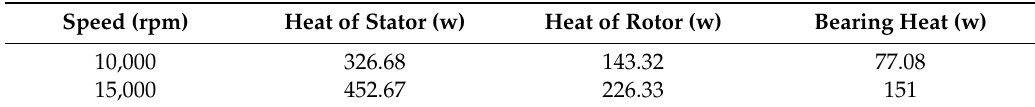
Table 3. The heat rates of the motorized spindle.